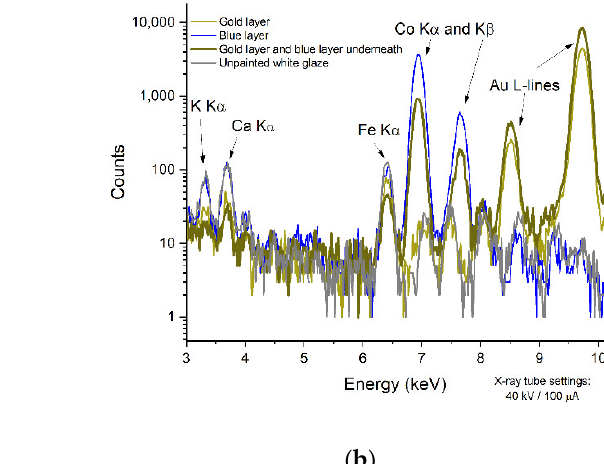
The PGAA spectrum taken at the central gilding indicated not only the presence of gold but also showed a strong correlation with the cobalt spectrum (see the correlated peaks at 230 and 236 keV of the golden-colored line in the Co plots of Figure 4), proving that underneath the gold layer the Sevres blue paint is present. This is also justified by the radiogram, as well as the anti-correlation of the matrix peaks Al, Si, K, and Ca with the thickness of the gilding/blue paint in the XRF spectrum (Figure 6).